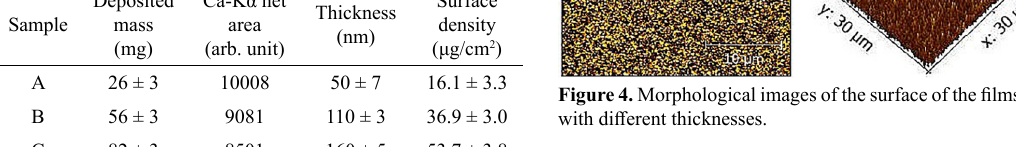
Figure 5. Diffraction of the thermally treated V